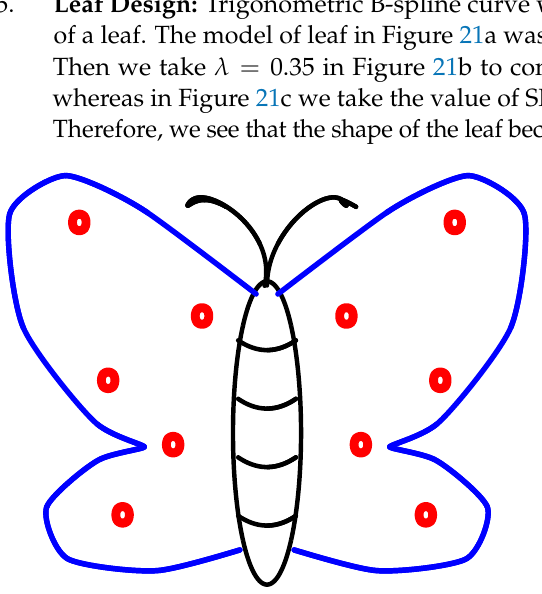
Figure 19. Butterfly designing using rational B-spline